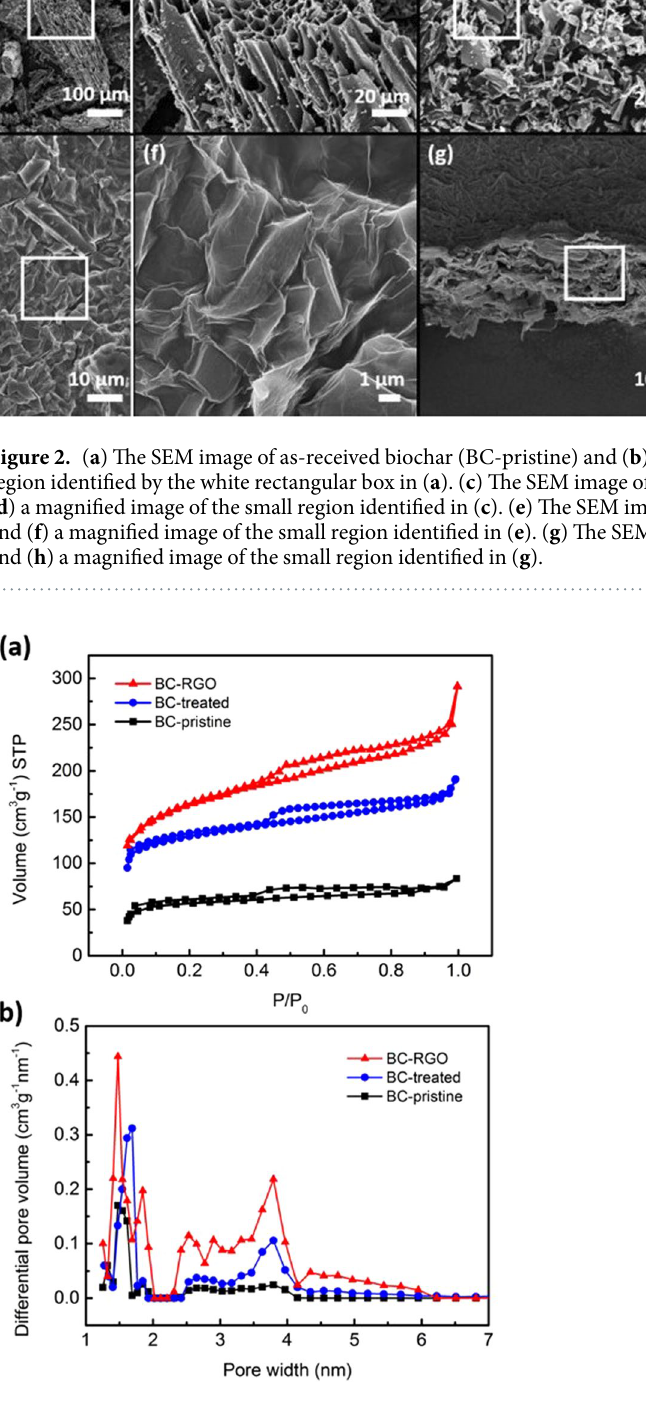
Figure 3. ( a ) Nitrogen adsorption isotherm according to the BET model and ( b ) Pore size distribution (represented as differential pore volume plotted against pore width) derived from ( a ), calculated with the NLDFT